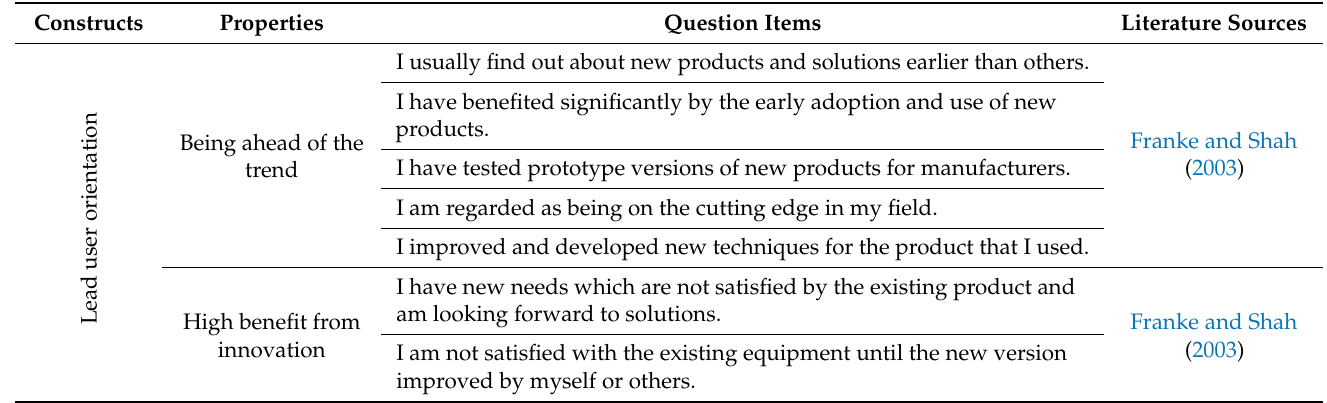
Table 1. The constructs and related question items of lead user orientation and entrepreneurial